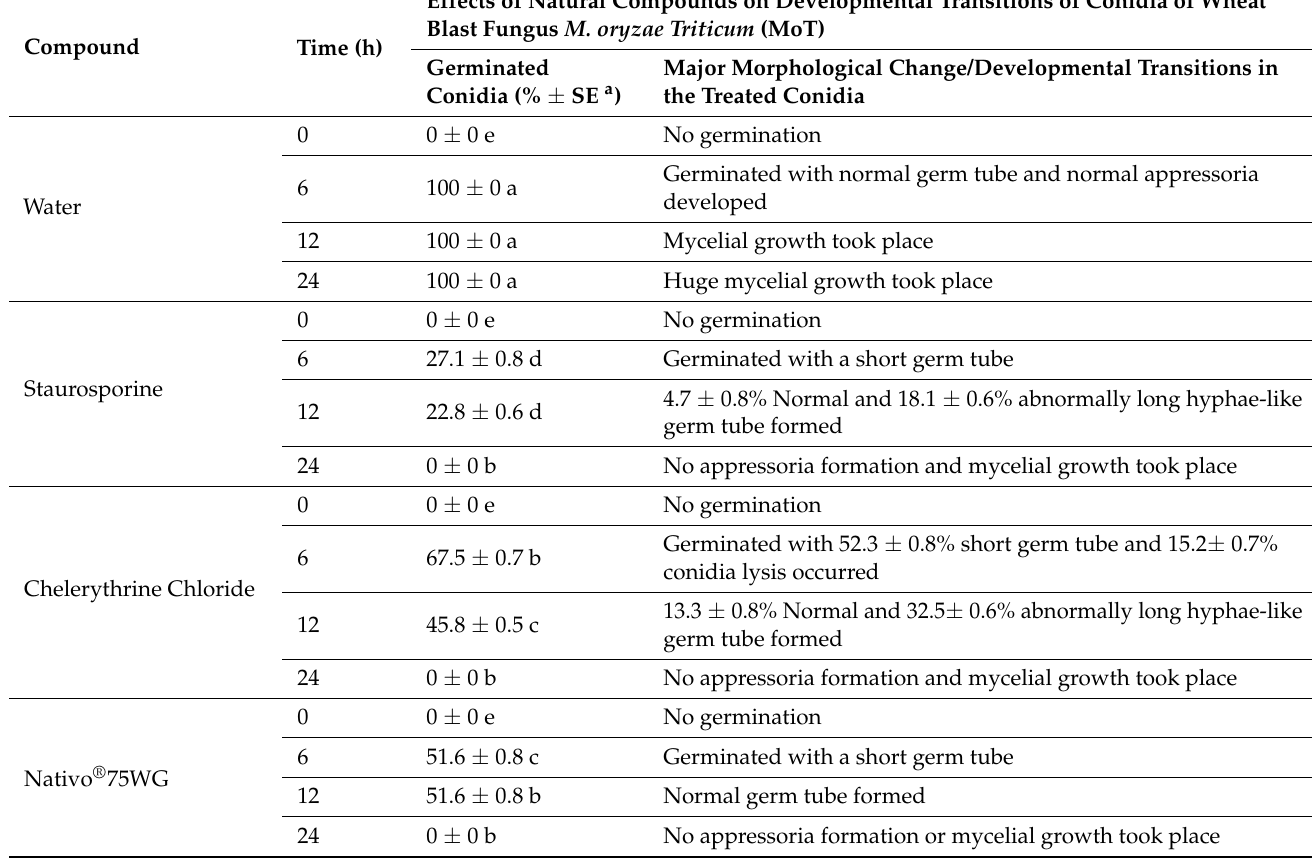
Table 1. Effects of staurosporine and chelerythrine chloride on Germination of Conidia and Their Subsequent Developmental Transitions of Magnaporthe oryzae Triticum (MoT) at the Dose of 0.05 µ g/mL In